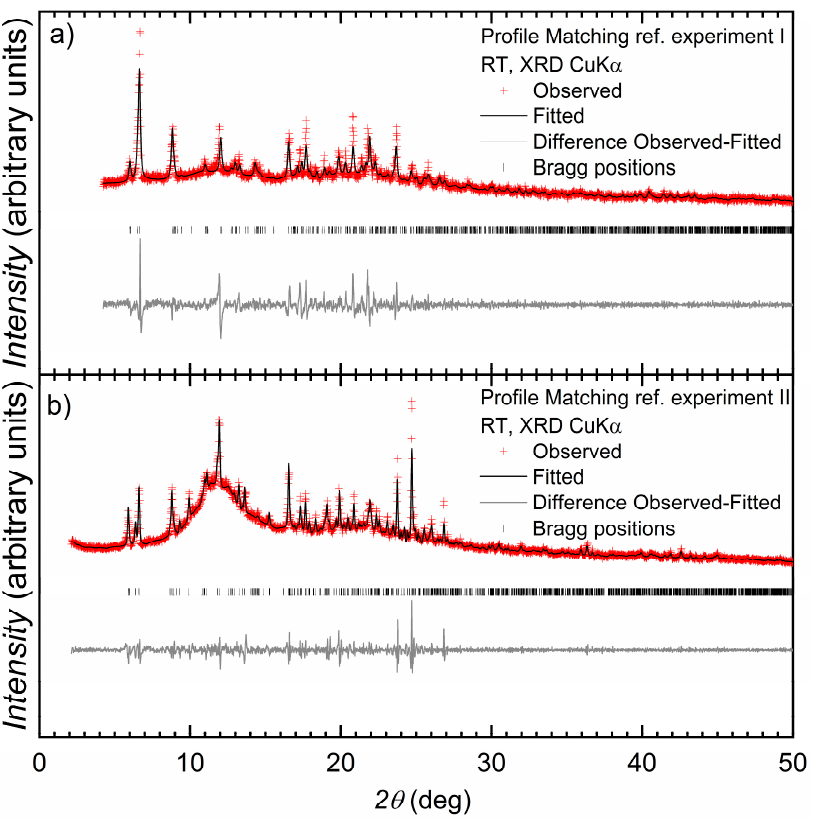
Figure 3. Laboratory X-ray di ff raction (CuK α 1 radiation) pattern (red crosses) of [{Co( 1 )(NCS) 2 } · MeOH · 3CHCl 3 ] n (experiment I) and [{Co( 2 )(NCS) 2 } · 0.8MeOH · 1.8CHCl 3 ] n (experiment II) (space group C 2 / c , No. 15) at room temperature. The black line corresponds to the best fit from the profile matching refinement. Lower vertical marks denote the Bragg peak positions for [{Co( 1 )(NCS) 2 } · MeOH · 3CHCl 3 ] n and [{Co( 2 )(NCS) 2 } · 0.8MeOH · 1.8CHCl 3 ] n phases. The bottom grey line represents the di ff erence between experimental and calculated points.